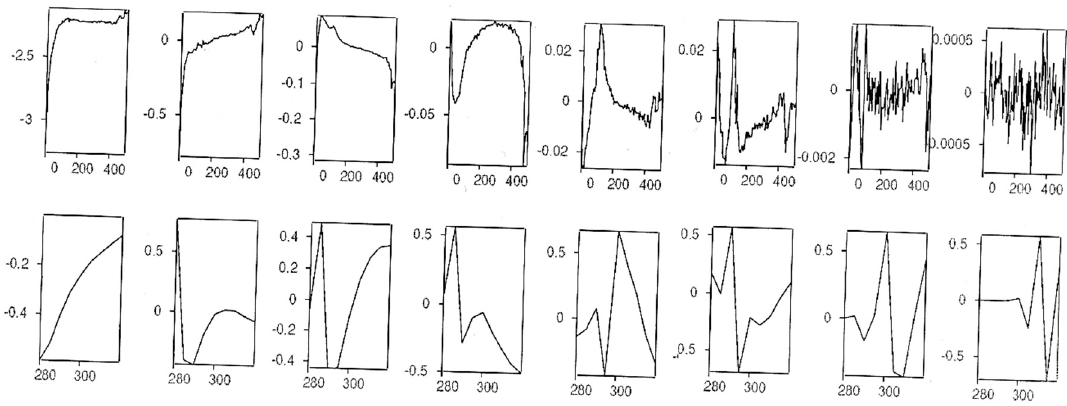
Figure 8. Basis spectra and time-dependent amplitudes derived from singular value decomposition (SVD) of the experimental matrix (only the first eight vectors displayed.)